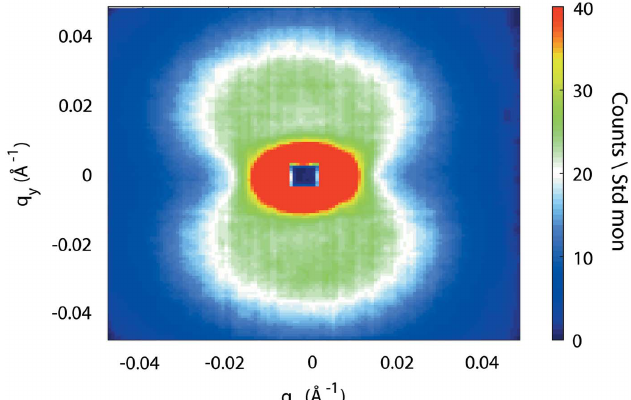
Figure 4 An example of the sum of the two spin-polarized SANS intensities I + + I (cid:3) with 35 sheets of Vitroperm. This is equivalent to an unpolarized SANS intensity.